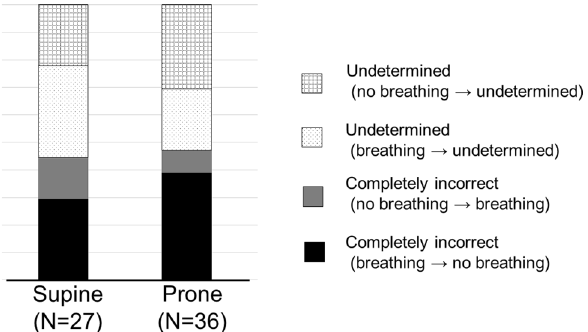
Figure 2. Incorrect responses for when the drone was kept hovering on the participants.